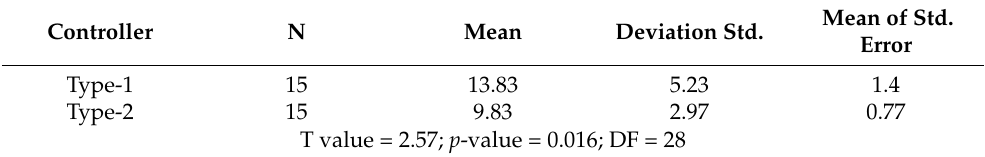
Table 8. Results for Student’s t -test using MSE error in type-1 and type-2 fuzzy controllers. Mean of Std. Controller N Mean Deviation std. Error Type-1 15 332 209 54 Type-2 15 43.9 26.7 6.9 T value = 5.31; p -value = 0.000; DF =